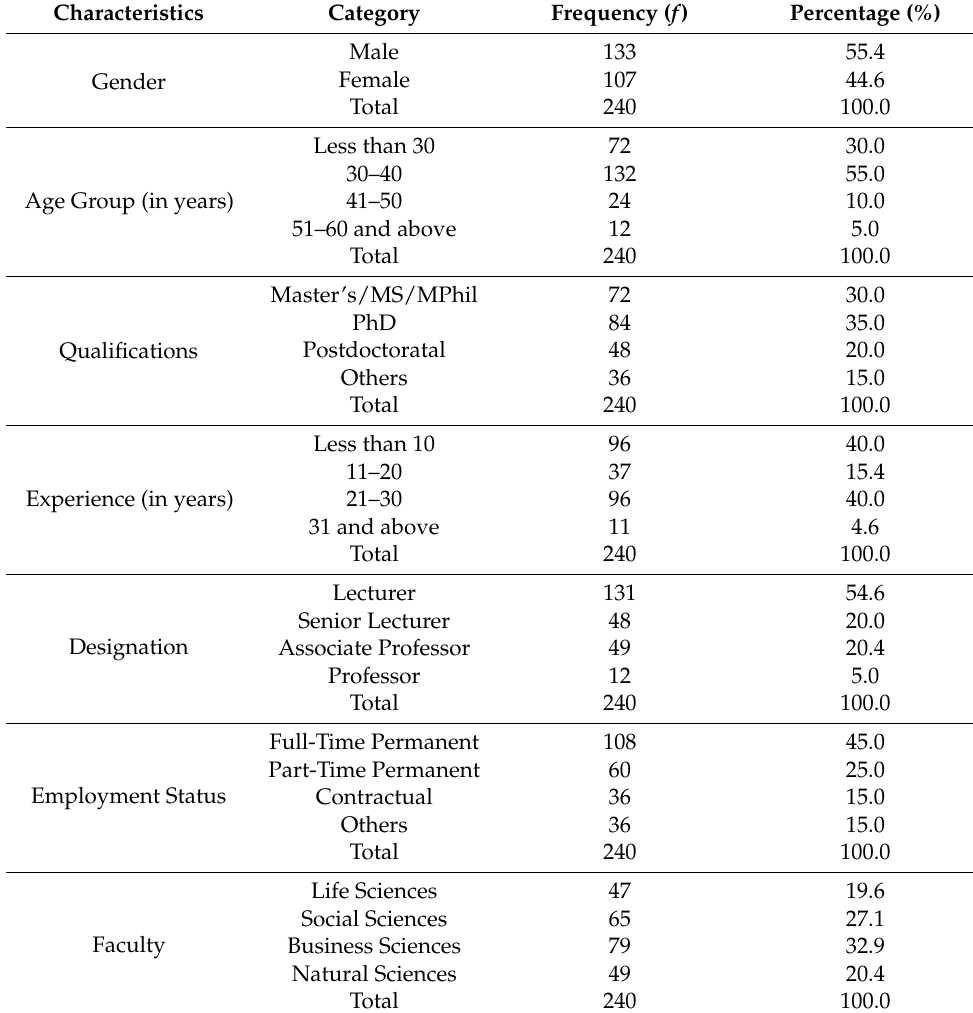
Table 1. Participants